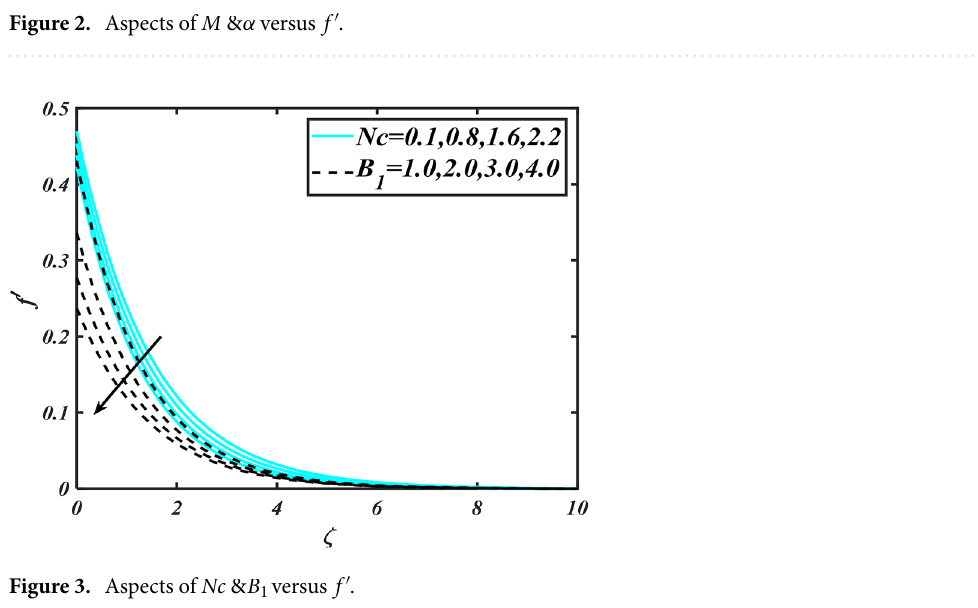
Figure 3. Aspects of Nc & B 1 versus f ′